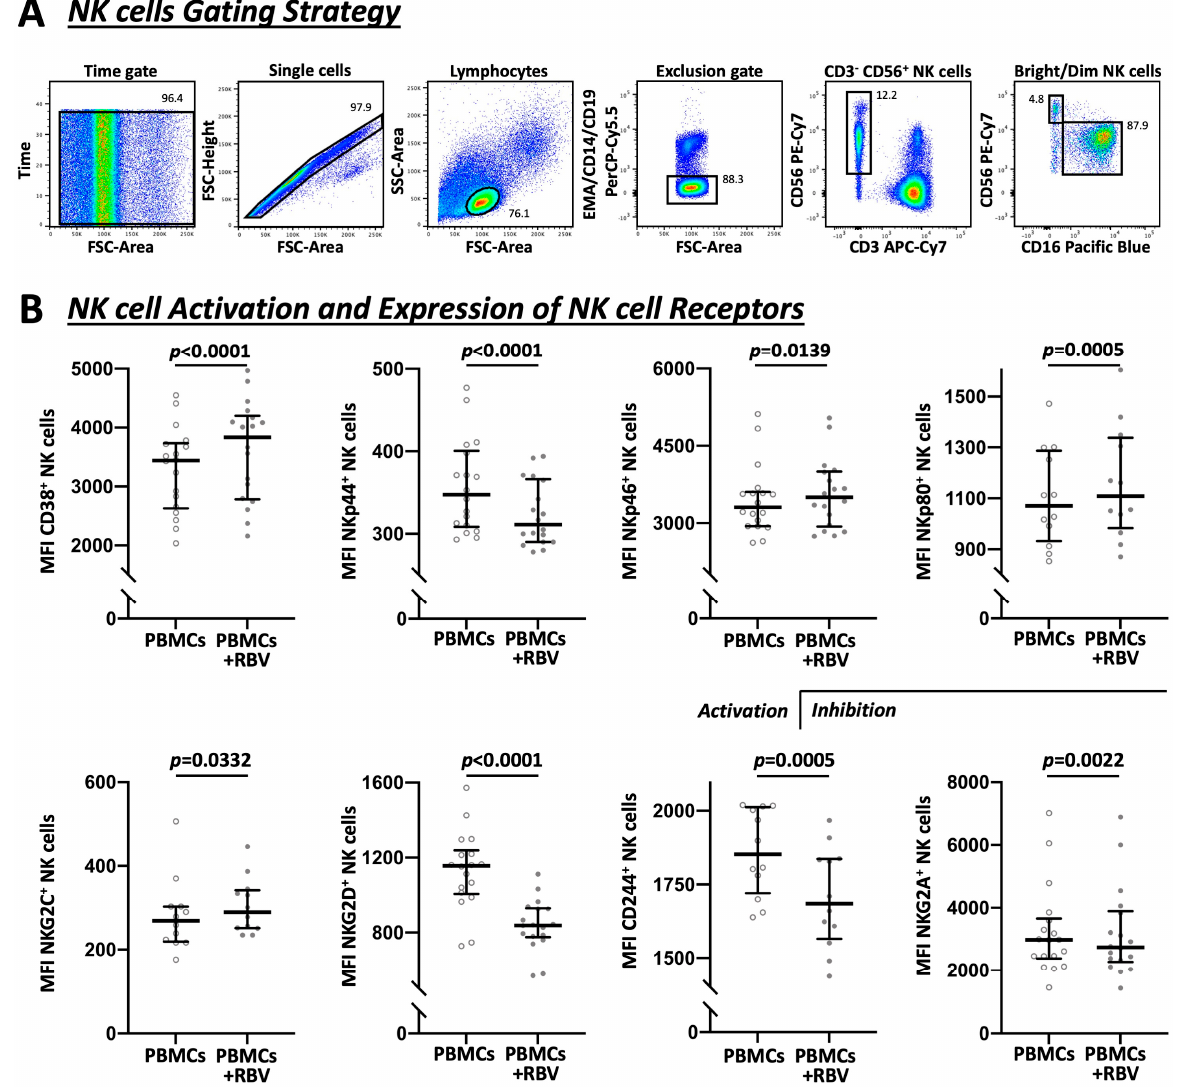
Figure 2. Flow cytometric analysis of NK cells and involved receptors under RBV treatment. ( A ) Exemplary gating strategy to show the sequence of identifying NK cells as CD3 − CD56 + PBMCs as well as the fractionation in dim (CD56 + CD16 + ) and bright (CD56 ++ CD16 − ) subpopulations. ( B ) Expression of affected NK cell receptors shown by MFI (n = 18 and n = 12). Appearance: median with interquartile range, statistical analysis: Wilcoxon matched-pairs signed-rank test.